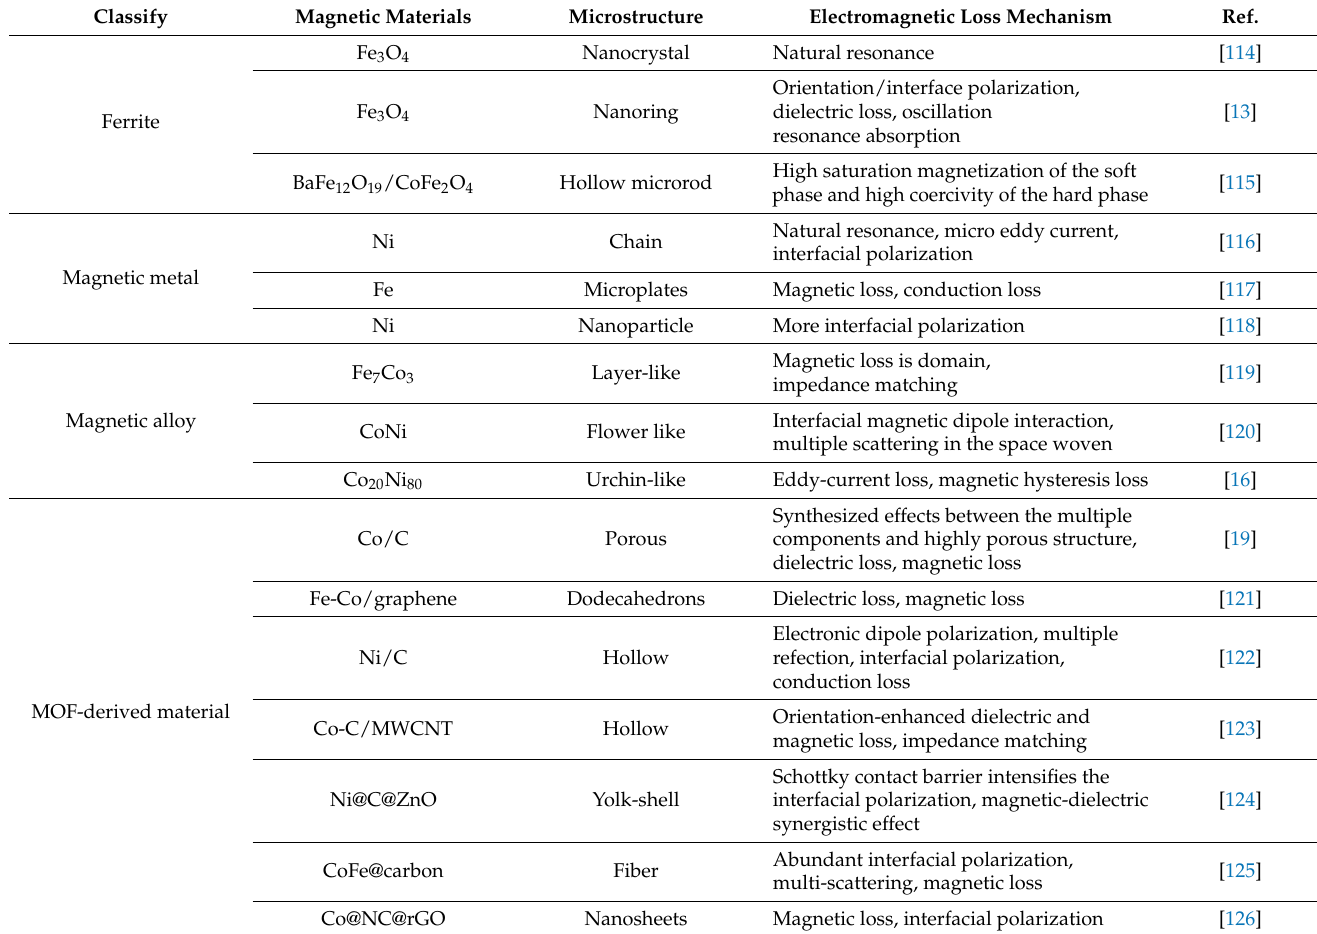
Table 2. The EM loss mechanism of magnetic